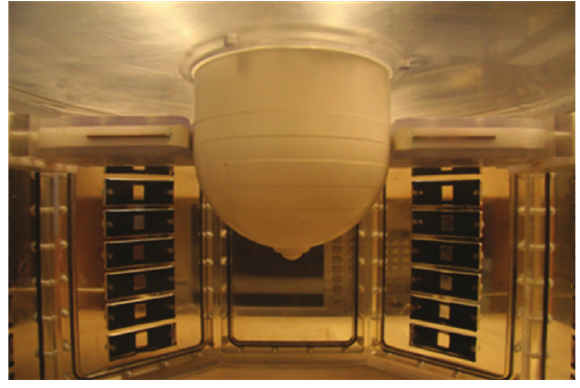
Figure 5: View of the low-loss breast model in the measurement tank. Picture was taken without the 2% saline for better clarity.